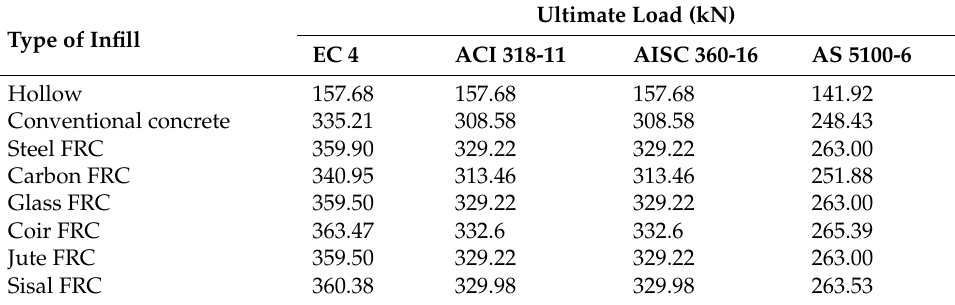
Table 5. Theoretical ultimate load for various CFST